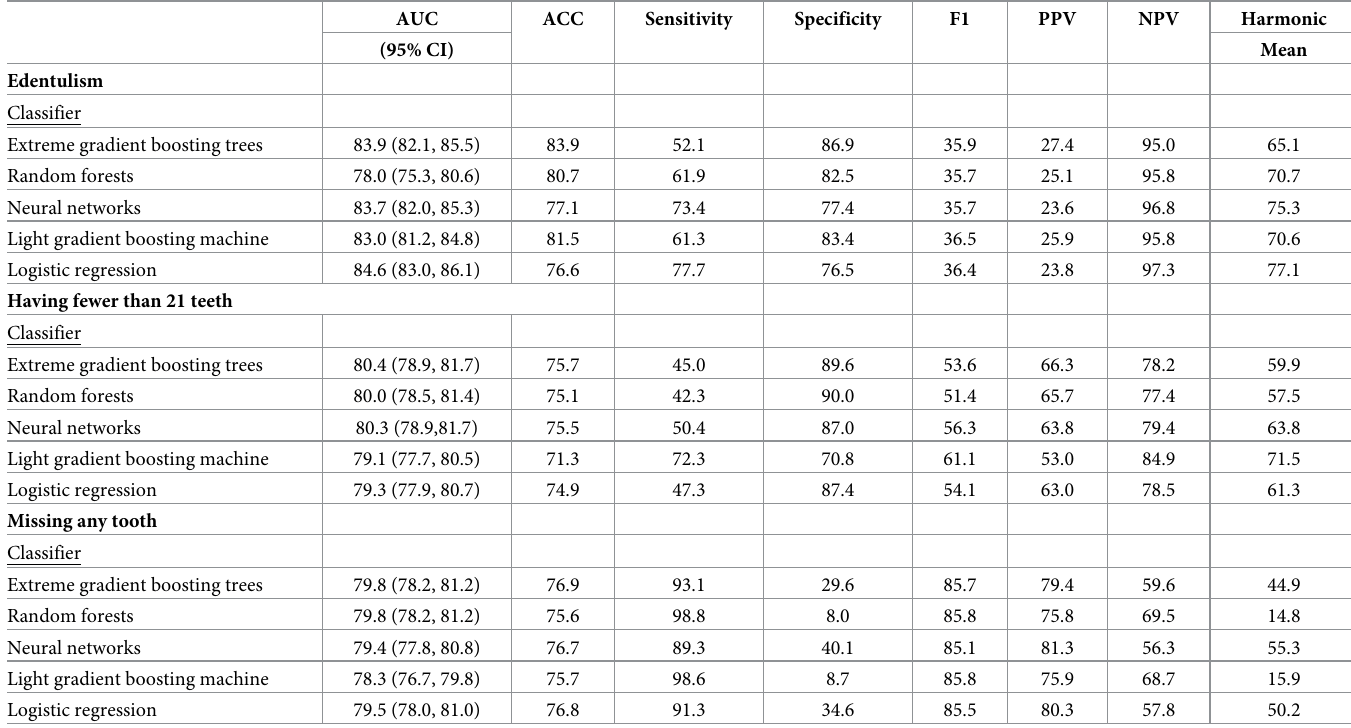
Table 3. Performance of the machine-learning algorithms on the test data for each study outcome when including clinical dental predictors a .